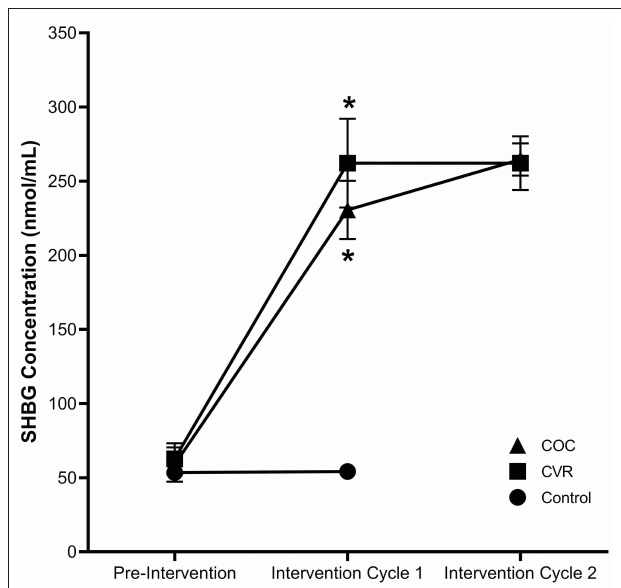
FIGURE 3 | Compliance to study period and study group. SHBG concentrations for the COC (triangle), CVR (square), and control (circle), groups for pre-intervention, intervention cycle 1, and intervention cycle 2 compliance assessments. COC, combined oral contraception; CVR, contraceptive vaginal ring. * indicates difference from control group at same time point p < 0.05.